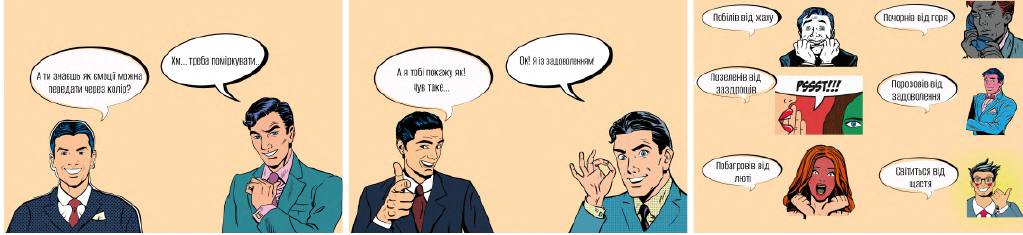
Figure 3: Episodes student-generated comic-based digital story where trainees expressed their ideas for associated meaning of different colors in interface